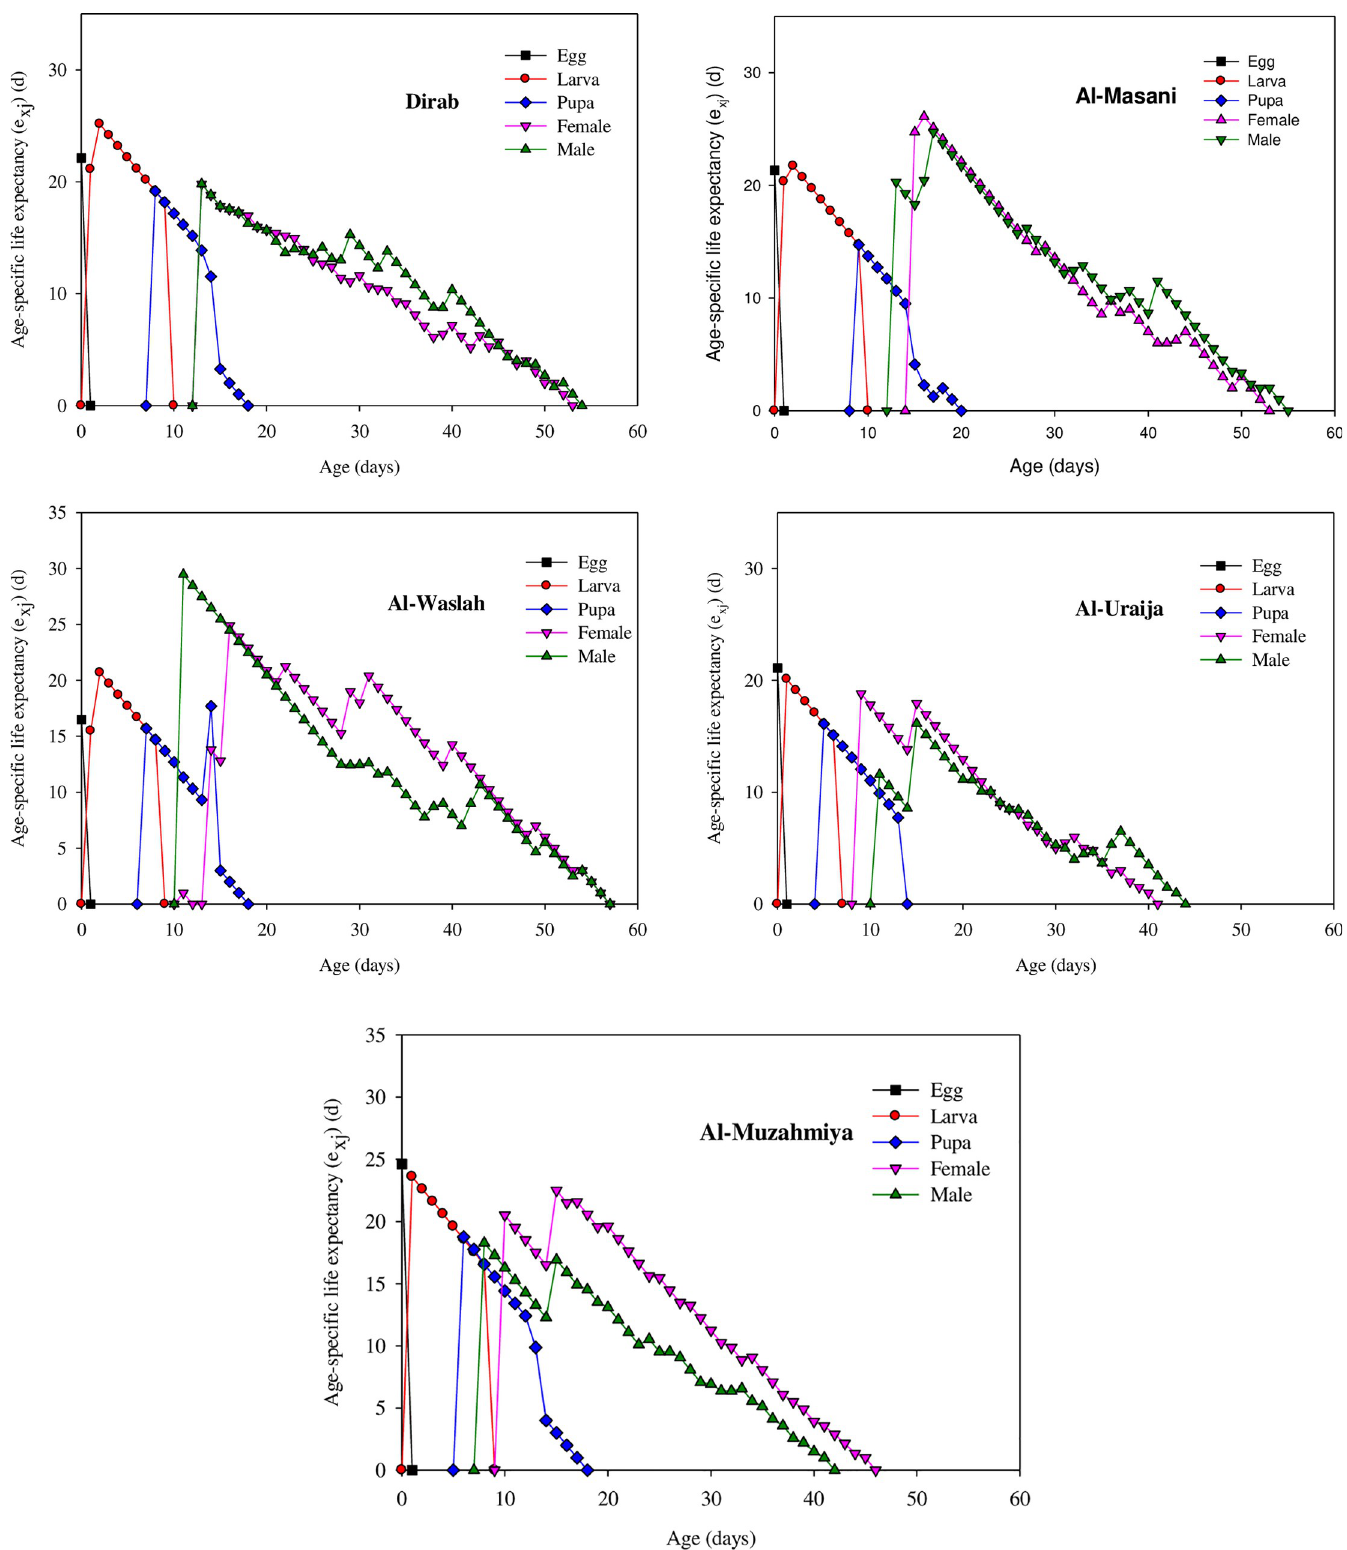
Fig 4. Age-specific life expectancy (e xj ) for the Dirab, Al-Masanie, Al-Washlah, Al-Uraija, and Al-Muzahmiya populations of house fly.